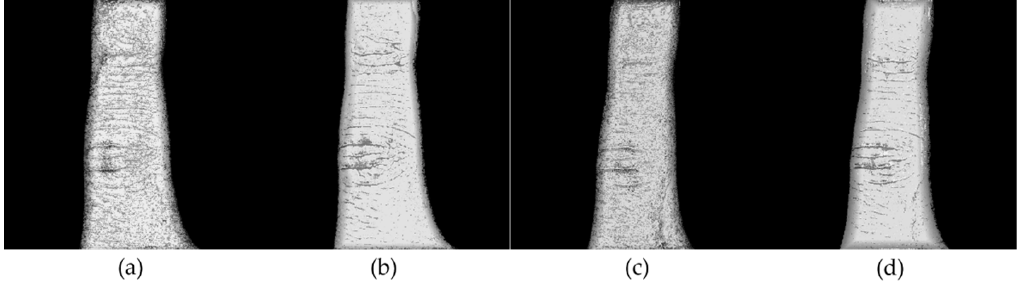
Figure 7. Results from the proposed hole-filling method: ( a , c ) show initial local disparity maps; ( b , d ) show refined local disparity maps obtained from hole-filling.